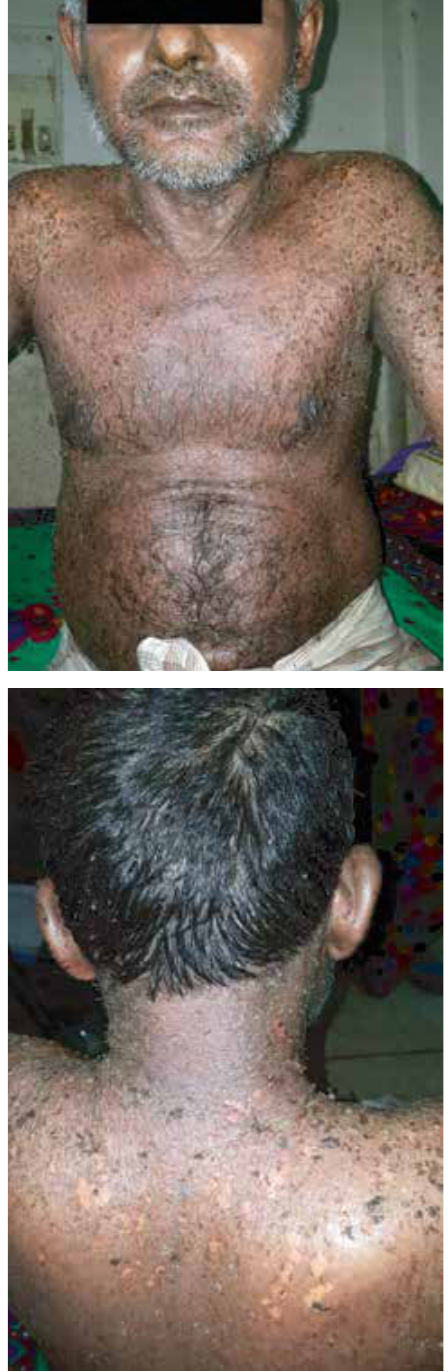
Fig 1. Morbiliform eruption that progressed to